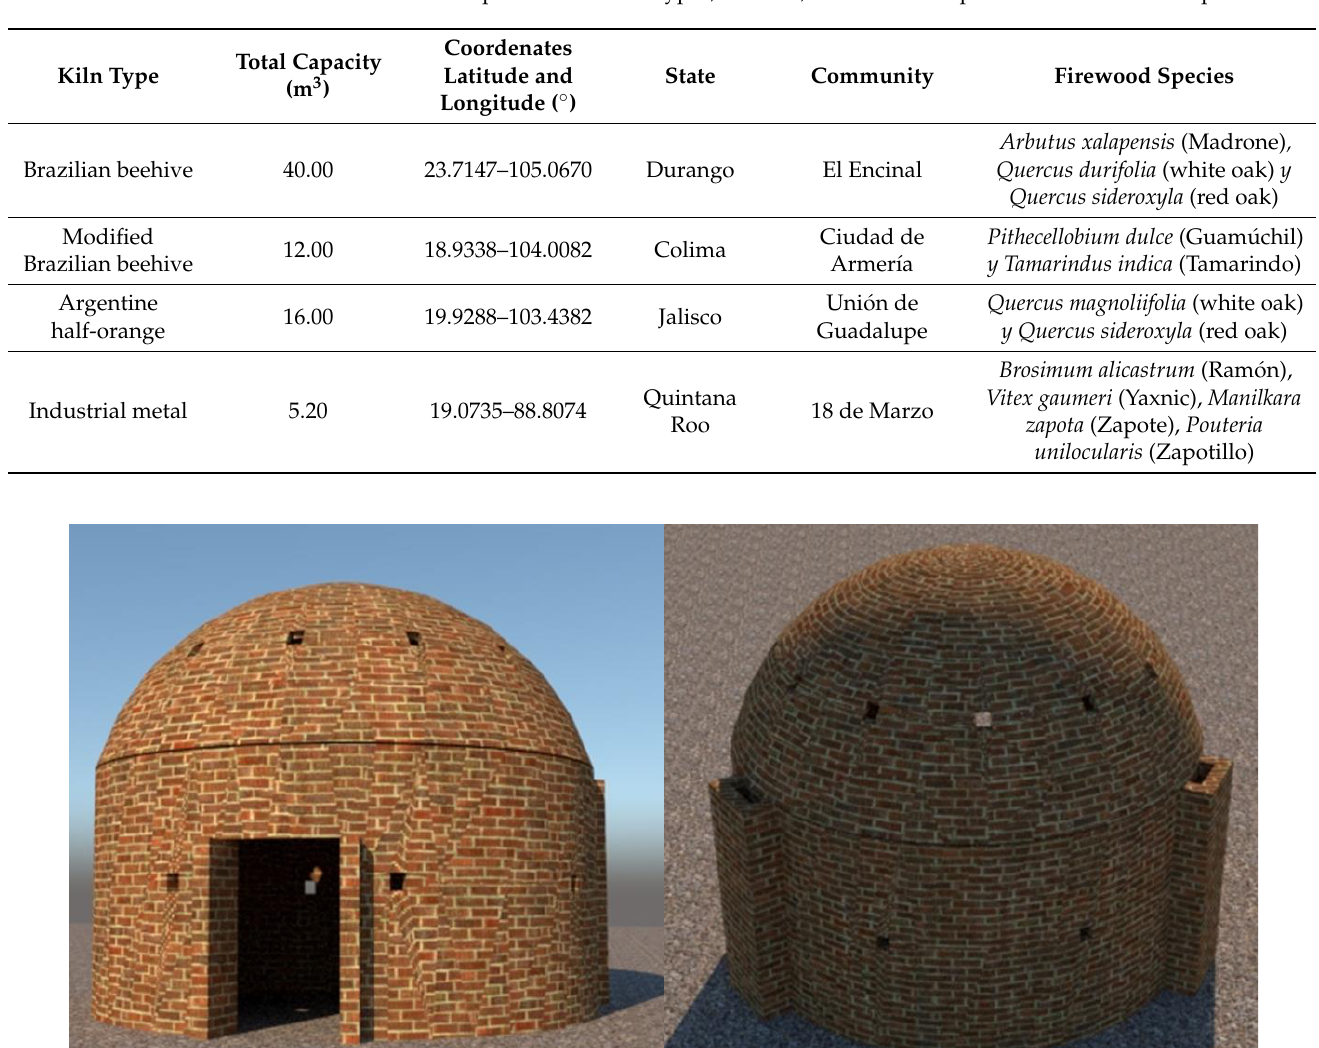
Table 1. Description of four kiln types, location, and firewood species used for charcoal production.